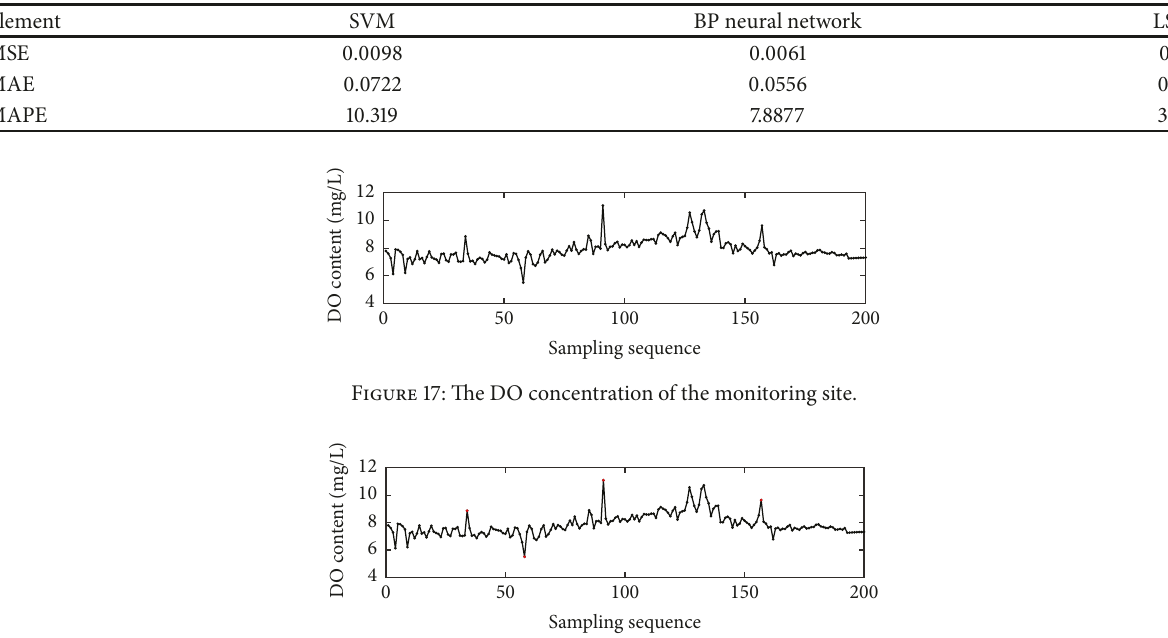
Table 3: Comparison results of the algorithm performance.